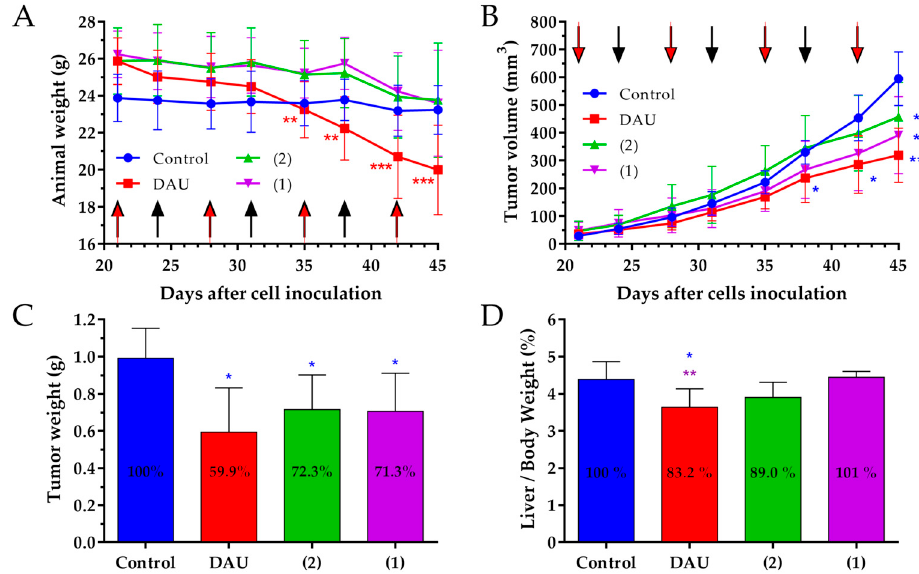
Int. J. Mol. Sci. 2019 , 20 , 4763 8 of 26 Figure 5. Effect of GnRH-III-Dau conjugates 1 and 2 (10 mg/kg Dau content, 6 treatments) and free Dau (1 mg/kg, 3 treatments) in orthotopic 4T1 mice breast carcinoma bearing mice. ( A ) Number of macro-metastases in peripheral organs (average % of control ± SD). ( B ) Effect of GnRH-III-Dau conjugates on the number of micro-metastases in lung (average number ± SD). ( C ) Proliferation of metastases in lung (average proliferation index ± SD). Statistical analysis was performed by Mann–Whitney test. *, ** and *** mean significant at p < 0.05, p < 0.01 and p < 0.001, respectively. * blue mean significant difference compared to control group (B,C). 2.8. Effect of GnRH-III-Dau Conjugates and Free Dau in Orthotopic MDA-MB-231 Human Breast Tumor Model In Vivo The effect of the GnRH-III conjugates 1 and 2 , as well as Dau on the animal body weight was evaluated in orthotopic MDA-MB-231 human breast carcinoma bearing mice (Figure 6A). In all the